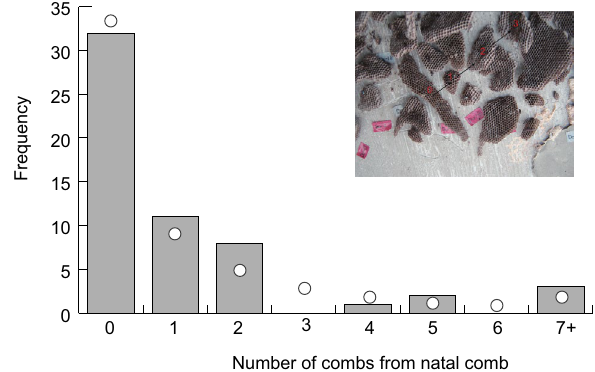
Figure 2. The number of individuals marked in the previous season that was re-sighted the following spring. The inset explains how to count the number of combs starting from the natal comb: 0 indicates a natal comb, and 3 indicates the third comb from the natal comb on which a focal foundress was re-sighted the following spring. We counted the smallest number of combs between the natal comb and the comb where the individual was re-sighted; in this case, three. The frequency distribution did not differ from a negative binomial distribution, representing a contagious distribution